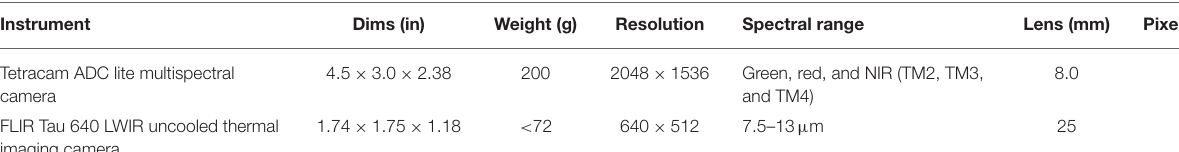
TABLE 2 | Specifications of the two cameras mounted on the UAV. Instrument